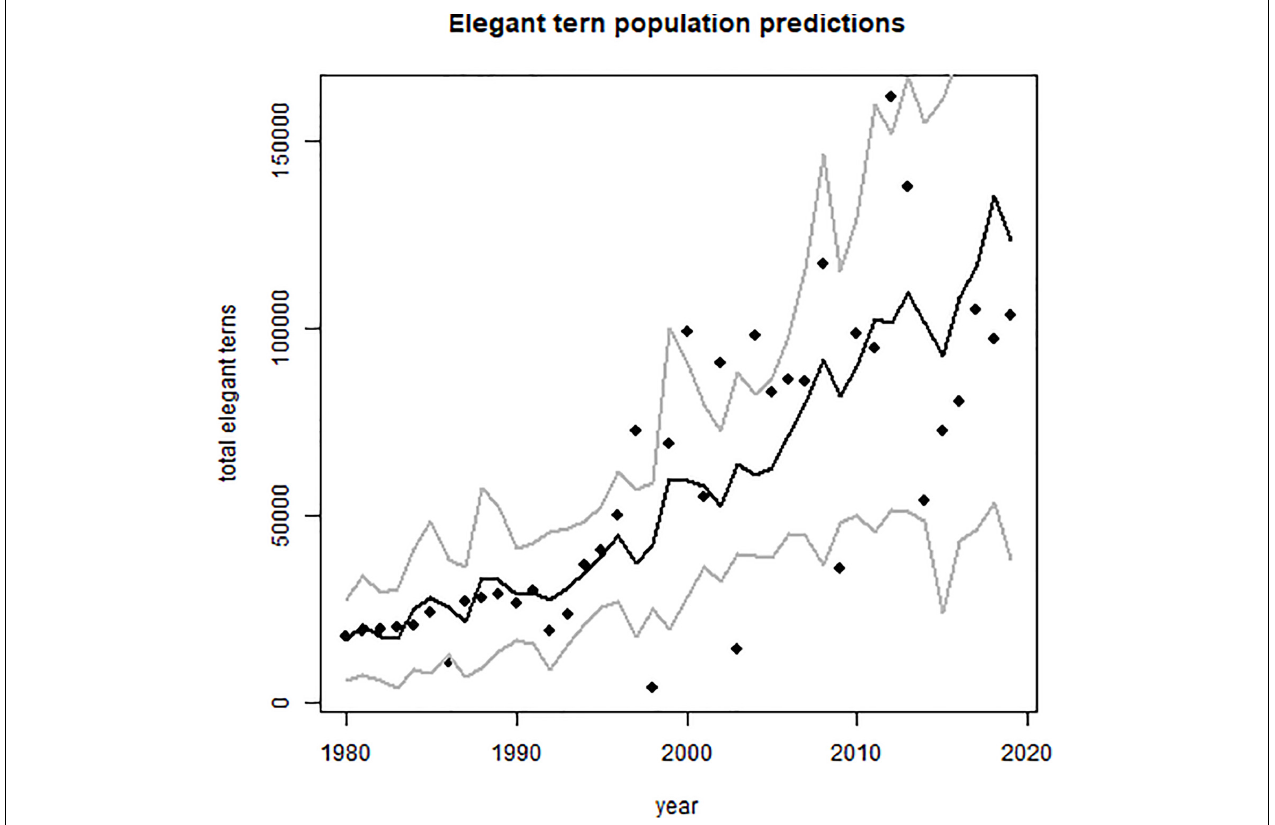
FIGURE 1 | Growth of core area population of elegant terns, summed over Isla Rasa plus Southern California colonies 1980–2019 [1980 to 2014 taken from Velarde et al. (2015), 2015 to 2019 from M. Horn and Velarde (unpubl.)]. Statistical support in Table 2 . Predicted values and confidence limits shown.